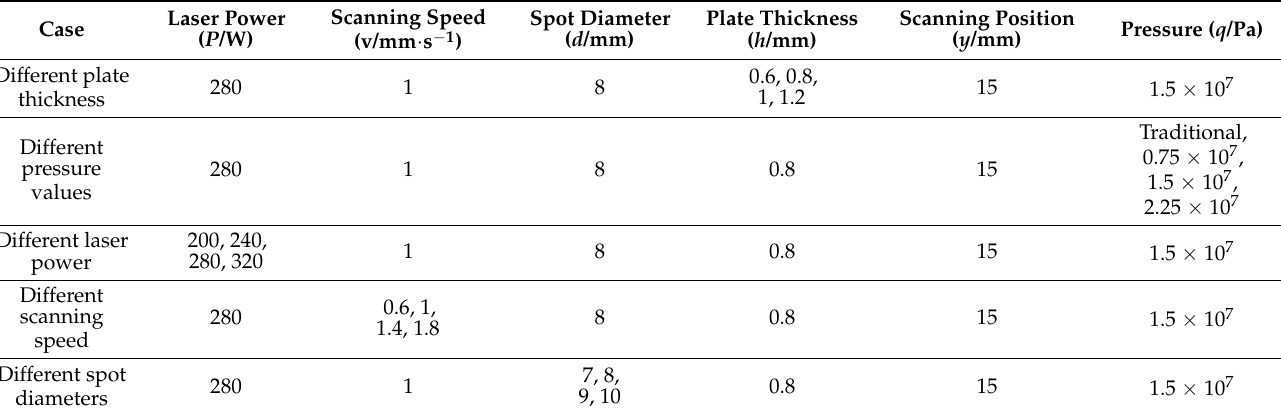
Figure 4. Thermophysical parameters at different temperatures. The selected parameters are presented in Table 1. Table 1. Processing